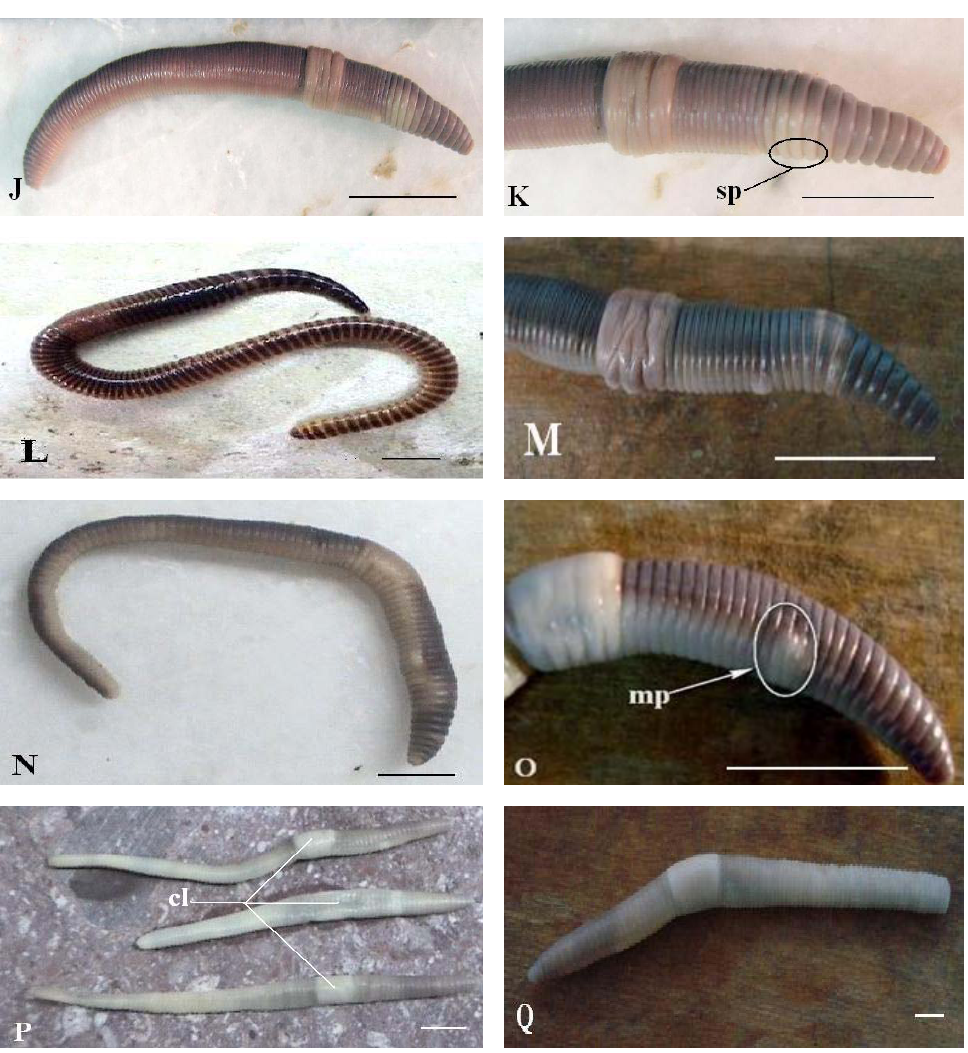
F IGURE 2. - J,K) Dendrobaena hortens is (sp: spermathecae pores), L,M) Dendrobaena veneta , N,O) Dendrobaena octaedra ( mp: male pores) , P,Q) Dendrodrilus rubidu s (cl: clitellum) scale= 1